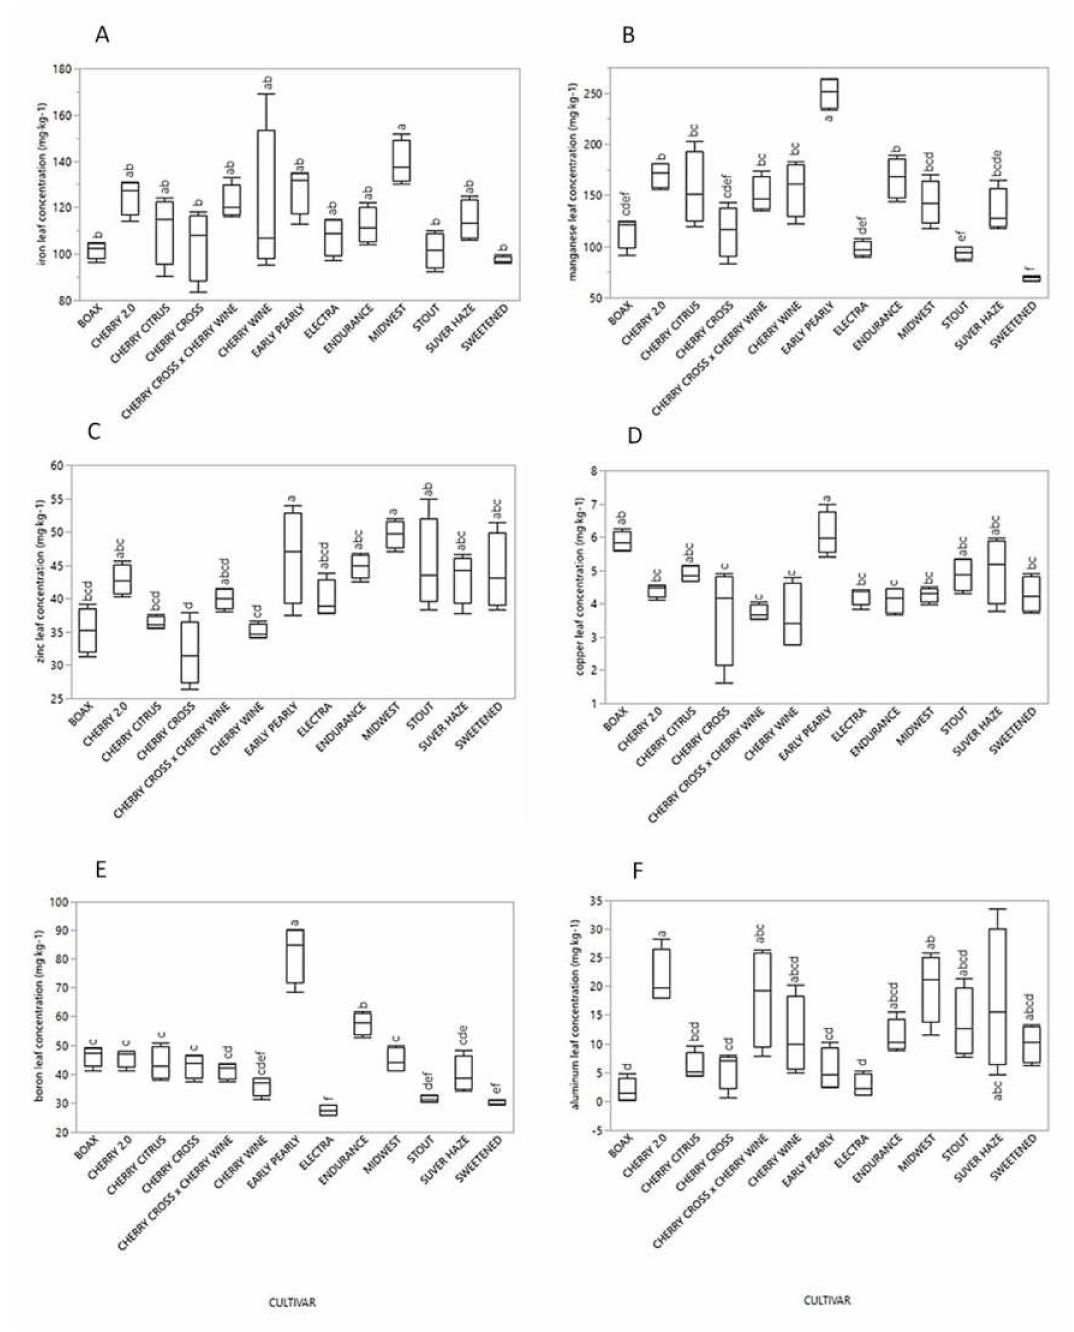
Figure 2. Leaf tissue micronutrient concentration ranges for thirteen greenhouse-propagated cannabidiol (CBD) hemp cultivars. Plants were 12 weeks old and in a vegetative stage of development prior to the excision of initial cuttings for propagation. ( A ) Iron, ( B ) manganese, ( C ) zinc, ( D ) copper, ( E ) boron, and ( F ) aluminum. Nutrient means that share similar lowercase letters within each graph are not significantly di ff erent from each other according to Tukey’s (HSD) Test at p >